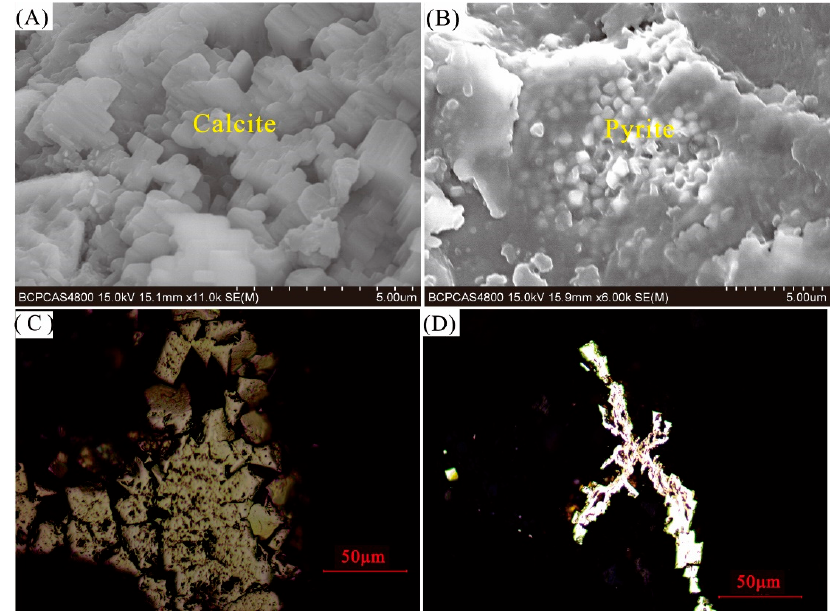
Figure 10. Calcite and pyrite in samples from Hebi No. 6 mine. ( A ) Calcite, sample HB-8, SEM images under SE mode; ( B ) massive and euhedral pyrite, sample HB-21, SEM images under SE mode; ( C ) massive pyrite, sample HB-21, reflected light, oil immersion; ( D ) fracture-filling pyrite, sample HB-22, reflected light, oil immersion.